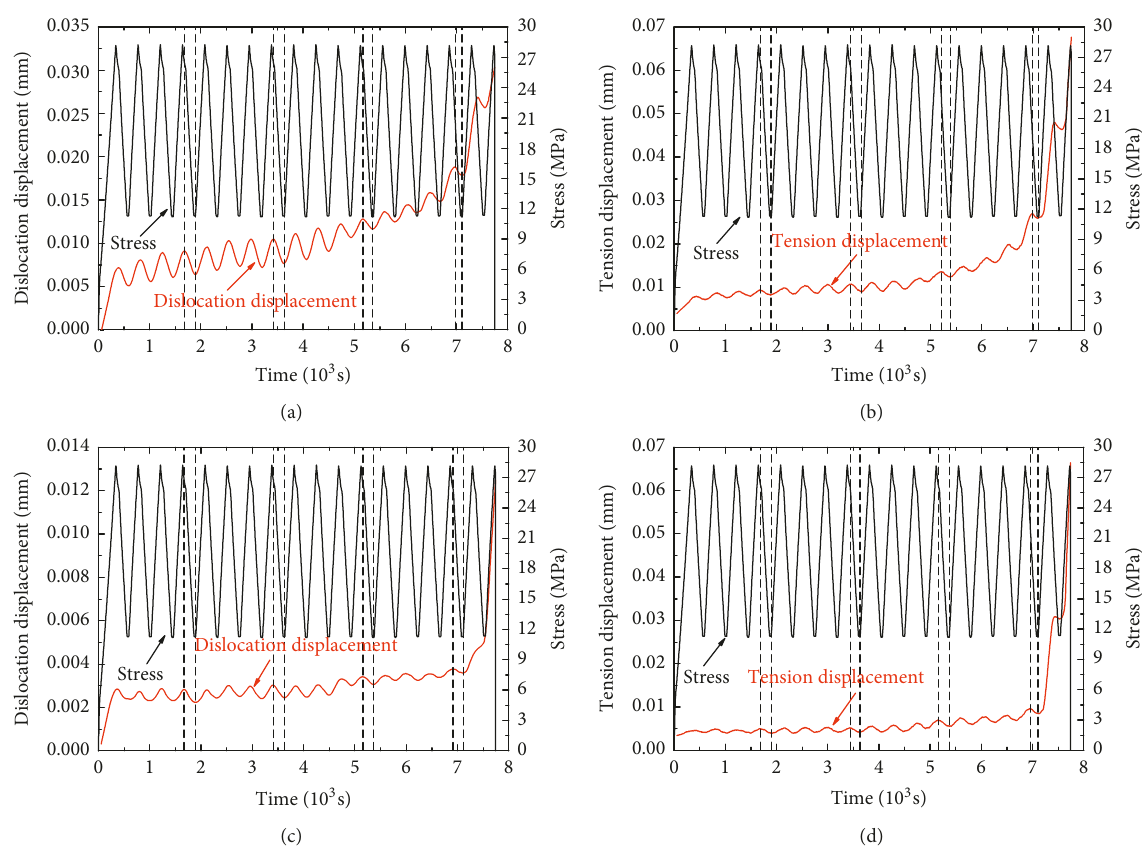
Figure 12: Displacement evolution curves around localization bands: (a) dislocation displacement of localization band A; (b) tension displacement of localization band A; (c) dislocation displacement of localization band B; (d) tension displacement of localization band